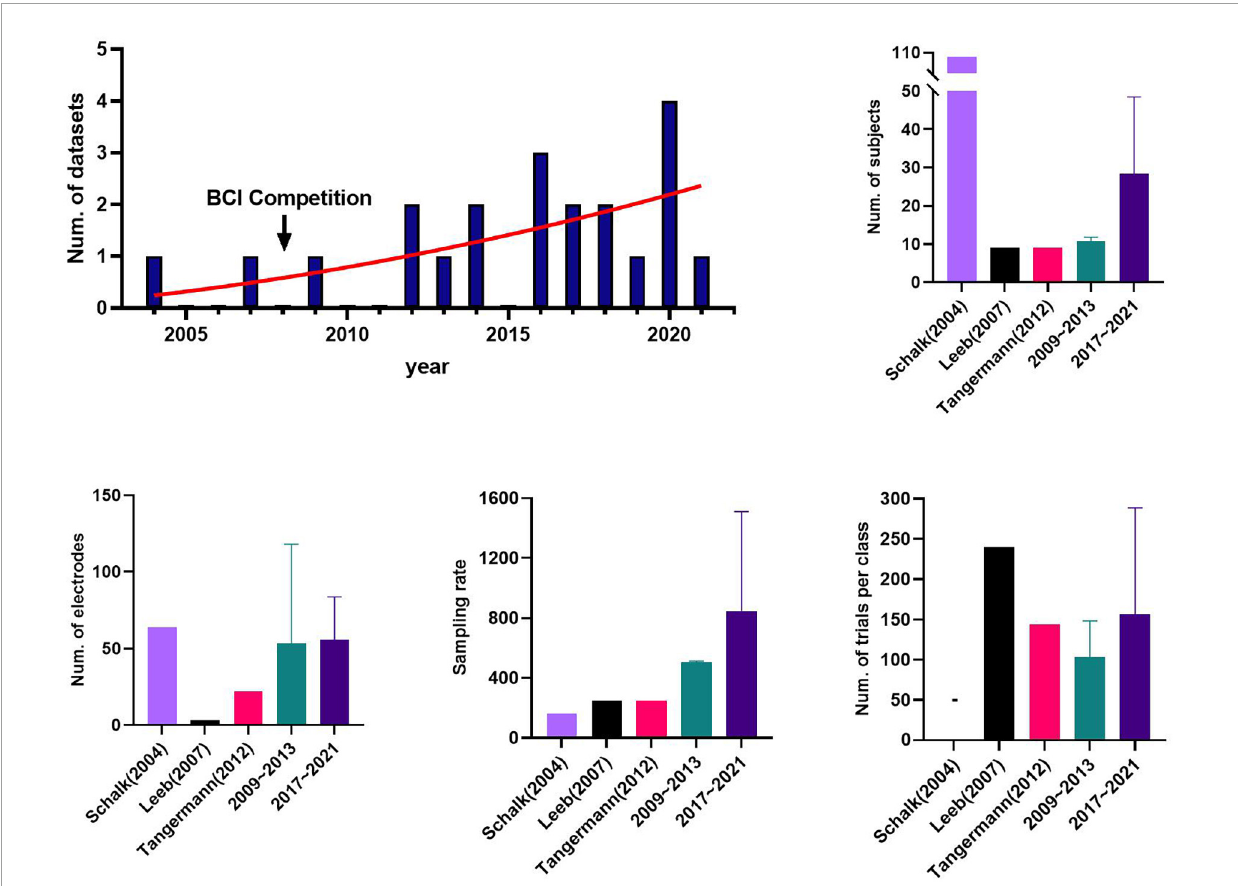
FIGURE1 The information of public datasets by years: brain-computer interface (BCI) competition datasets, Leeb et al. (2007) and Tangermann et al. (2012), the old datasets (2009 ∼ 2013); and the recent datasets (2017 ∼ 2021). Schalk et al. (2004), called PhysioNet project, was excluded due to its exceptionally large number of subjects and being too outdated. Stieger et al. (2021) was excluded from the recent datasets group only in calculating the number of trials per class. The error bar represents the standard